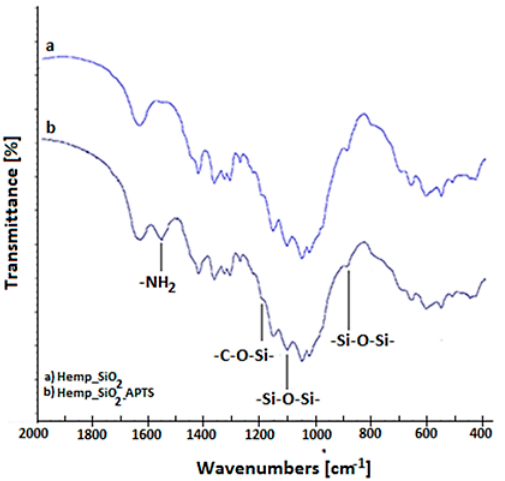
Figure 4. Spectra of a ) hemp fabric after functionalization with waterglass (Hemp_SiO 2 sample), b ) the spectrum recorded after the functionalization with APTS (Hemp_SiO 2 _ APTS sample).